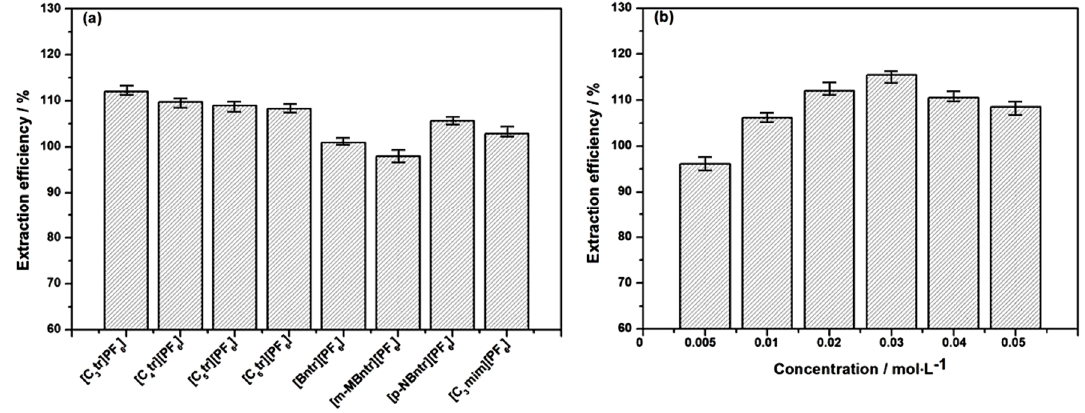
Figure 1. Extraction efficiency of various ILs ( a ) and concentrations ( b ). Table 2. The molar conductivities of seven tropine-type ionic liquids in aqueous